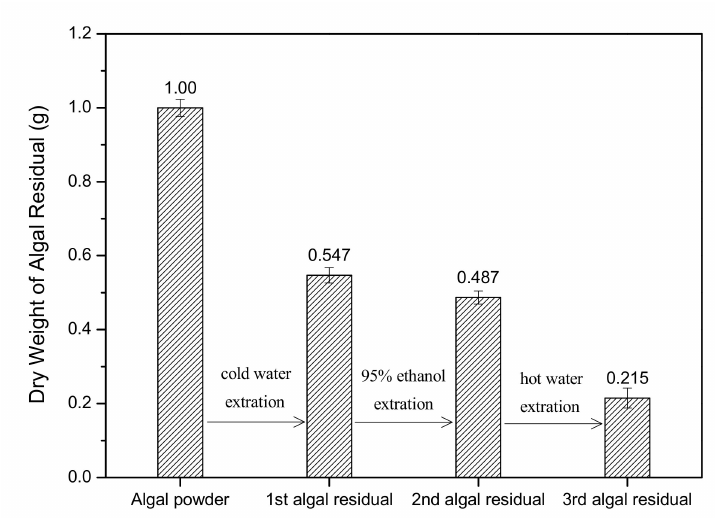
Figure 1. Biomass reduction during three-step extraction process ( n = 3; data: mean ±